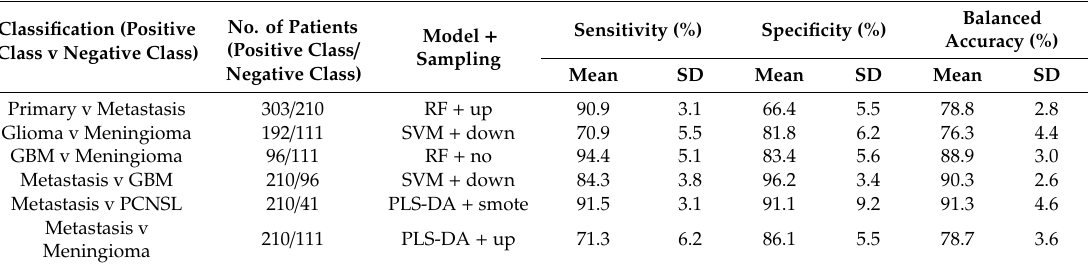
Table 3. The results from the optimal model for each brain tumour di ff erentiation. Sensitivity, specificity and balanced accuracy are reported as means and standard deviations calculated over 100